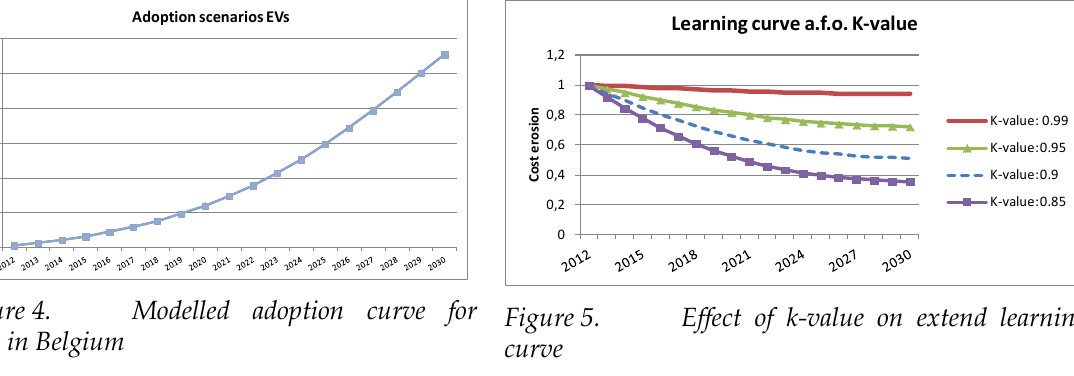
Figure 4. Modelled adoption curve for Figure 5. Effect of k-value on extend learning curve